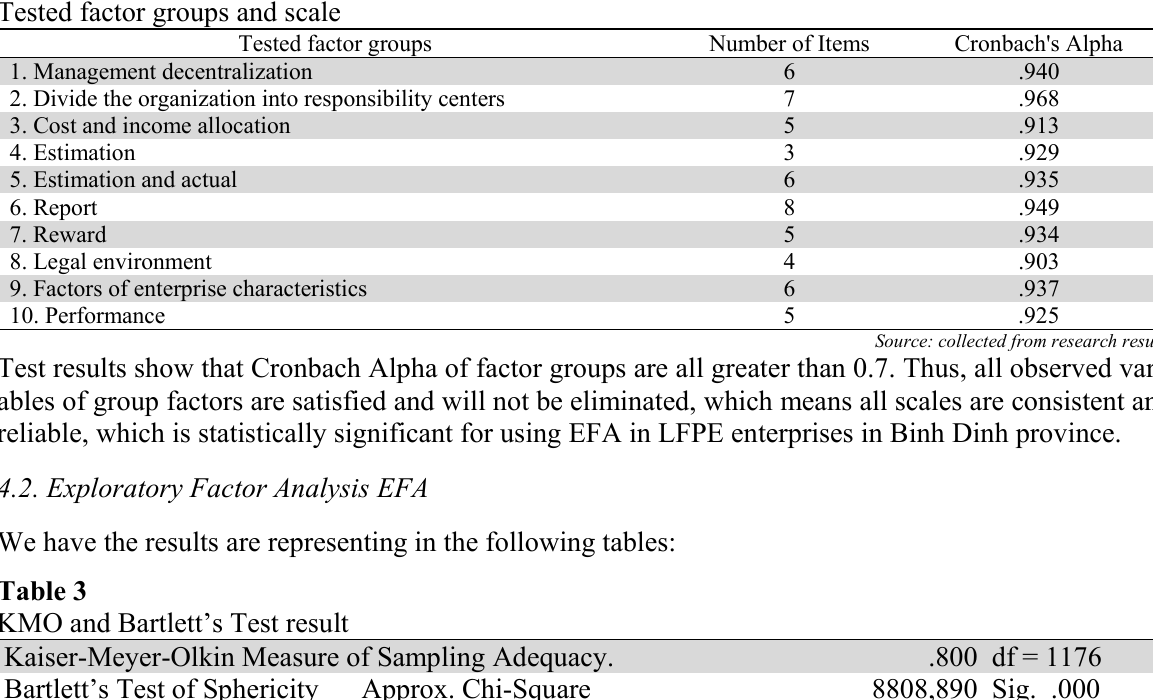
Total Variance Explained